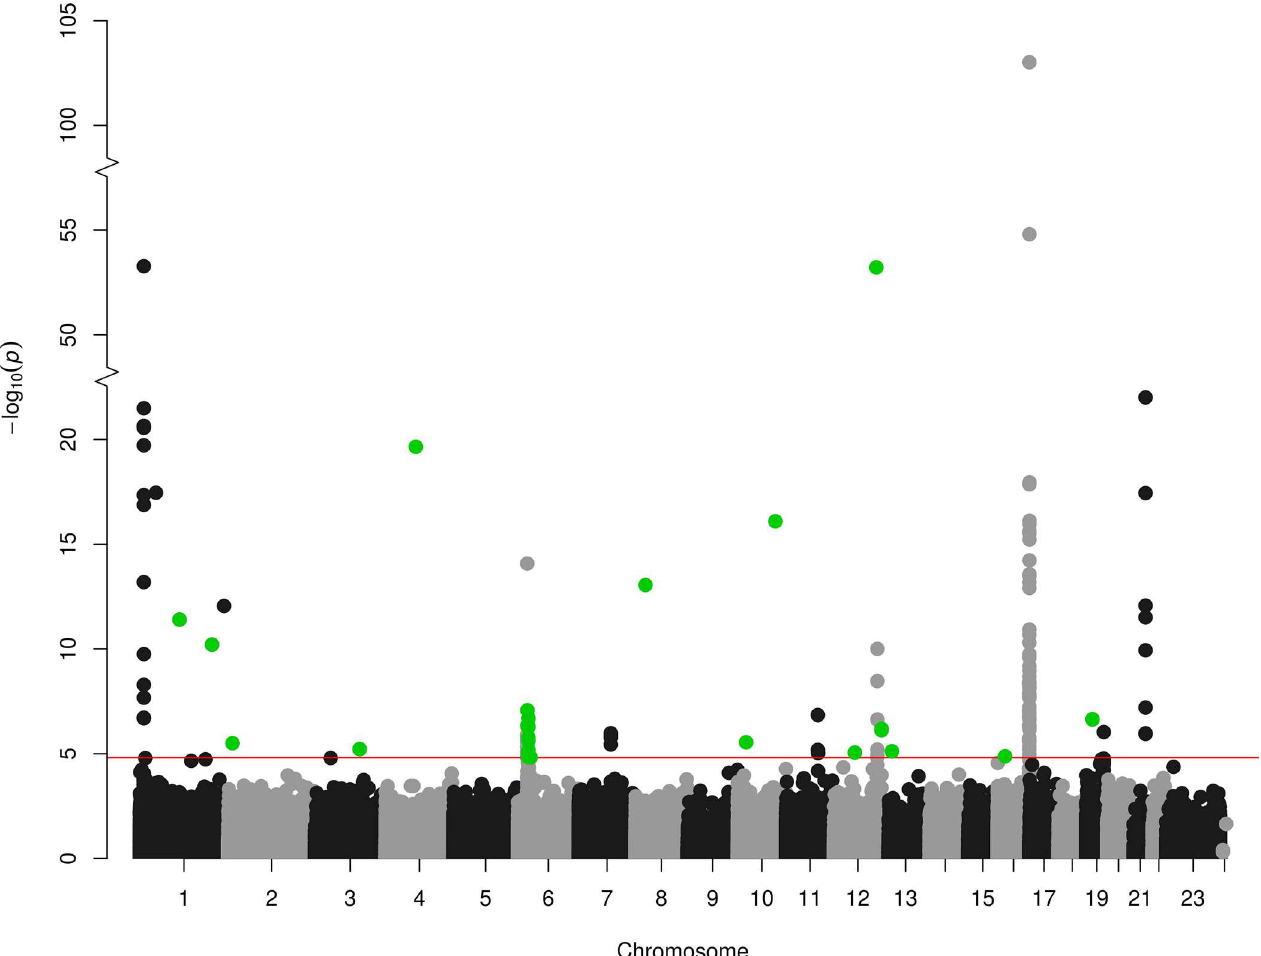
Fig 2. Manhattan plot. Association betweenGRS of 18 Hcy-associated SNPs and genome-wide DNA methylationin 9,894 samples,with 113 cis - meQTLs (black/grey) and 30 trans -meQTLs (green), at FDR < 0.05.